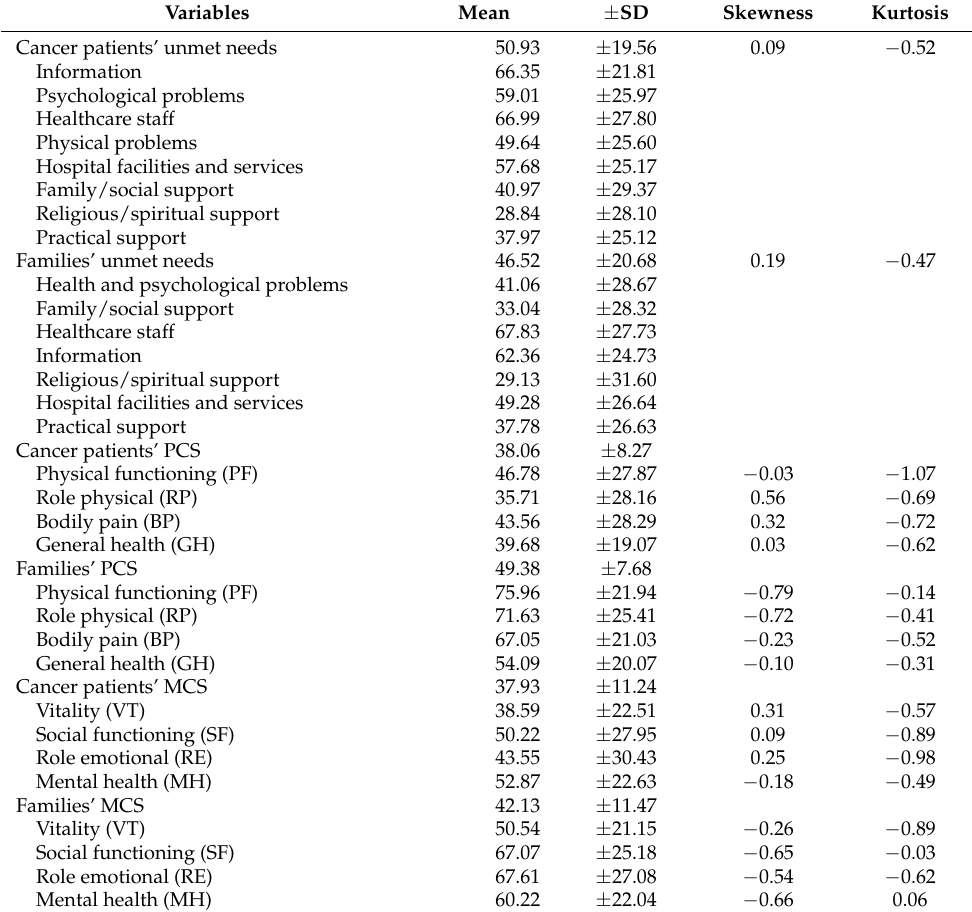
Table 2. Descriptive statistics of the measured variables ( N = 115 dyads).